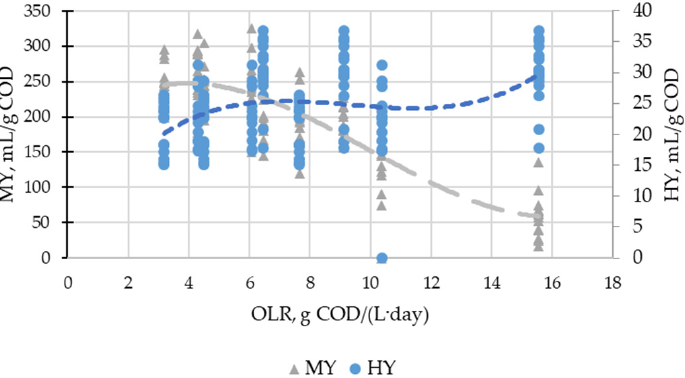
Figure 3. Dependence of methane yield (MY) and hydrogen yield (HY) on OLR.